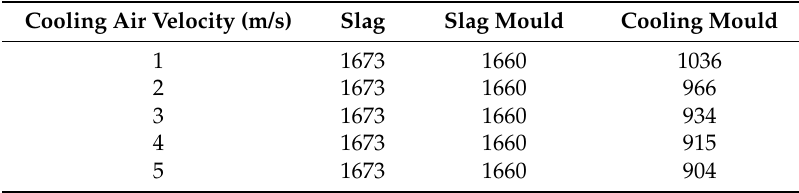
Table 4. Maximum temperature (K) of drum elements for each cooling air velocity considered (steel